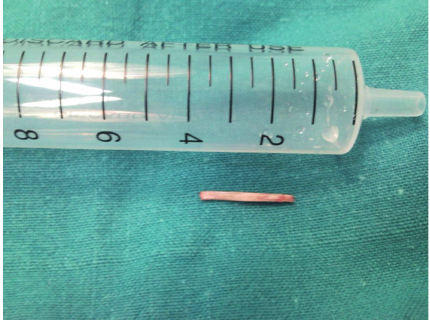
Figure 3: The impacted chicken bone after the surgical